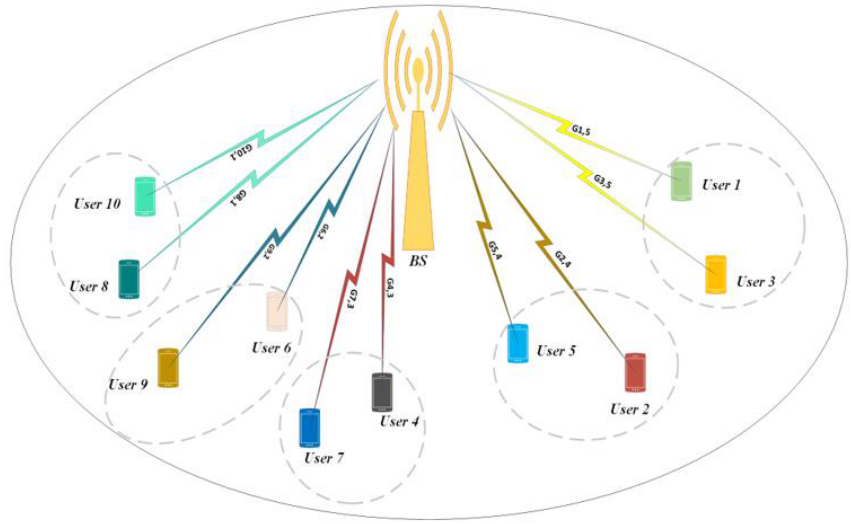
Figure 1. The basic concept of the NOMA scheme with 10 users.